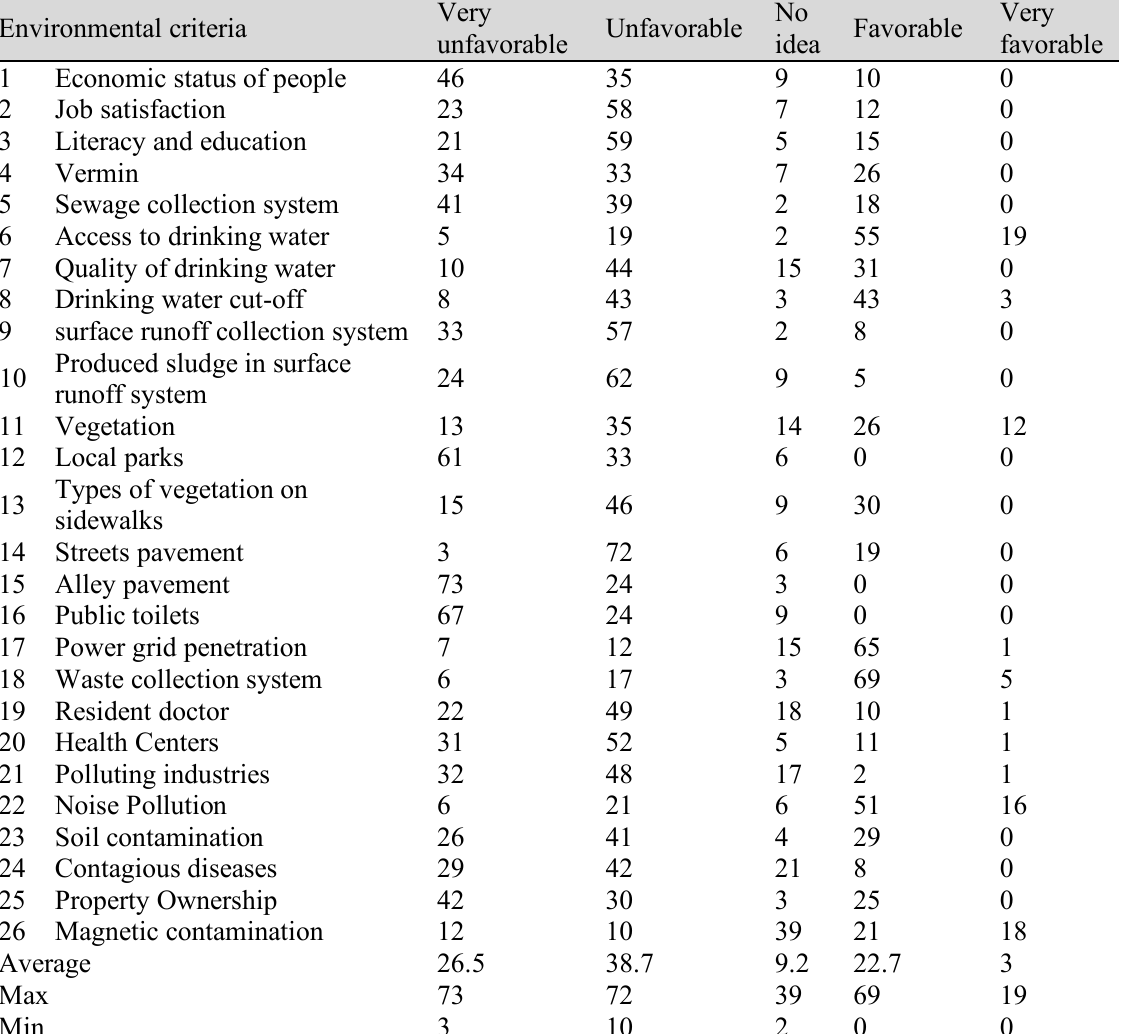
Table 3. Results of collected questionnaires Environmental